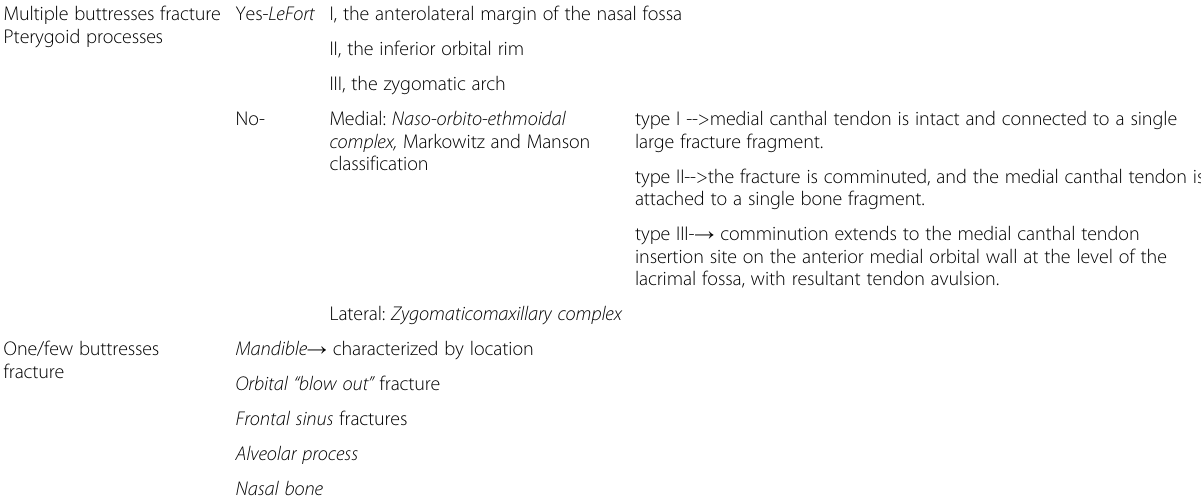
Table 2 Patterns and classifications of facial fractures Multiple buttresses fracture Pterygoid processes